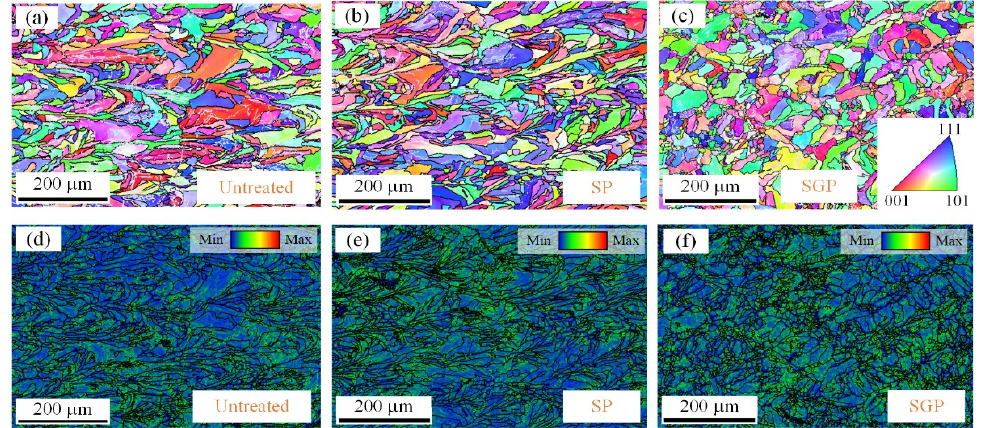
Figure 9. EBSD analyses of the IPF maps and KAM maps of the samples’ cross-sections: ( a – c ) crystal orientations of the untreated, SP, and SGP samples. ( d – f ) Kernel average misorientation distributions of the untreated, SP, and SGP samples.